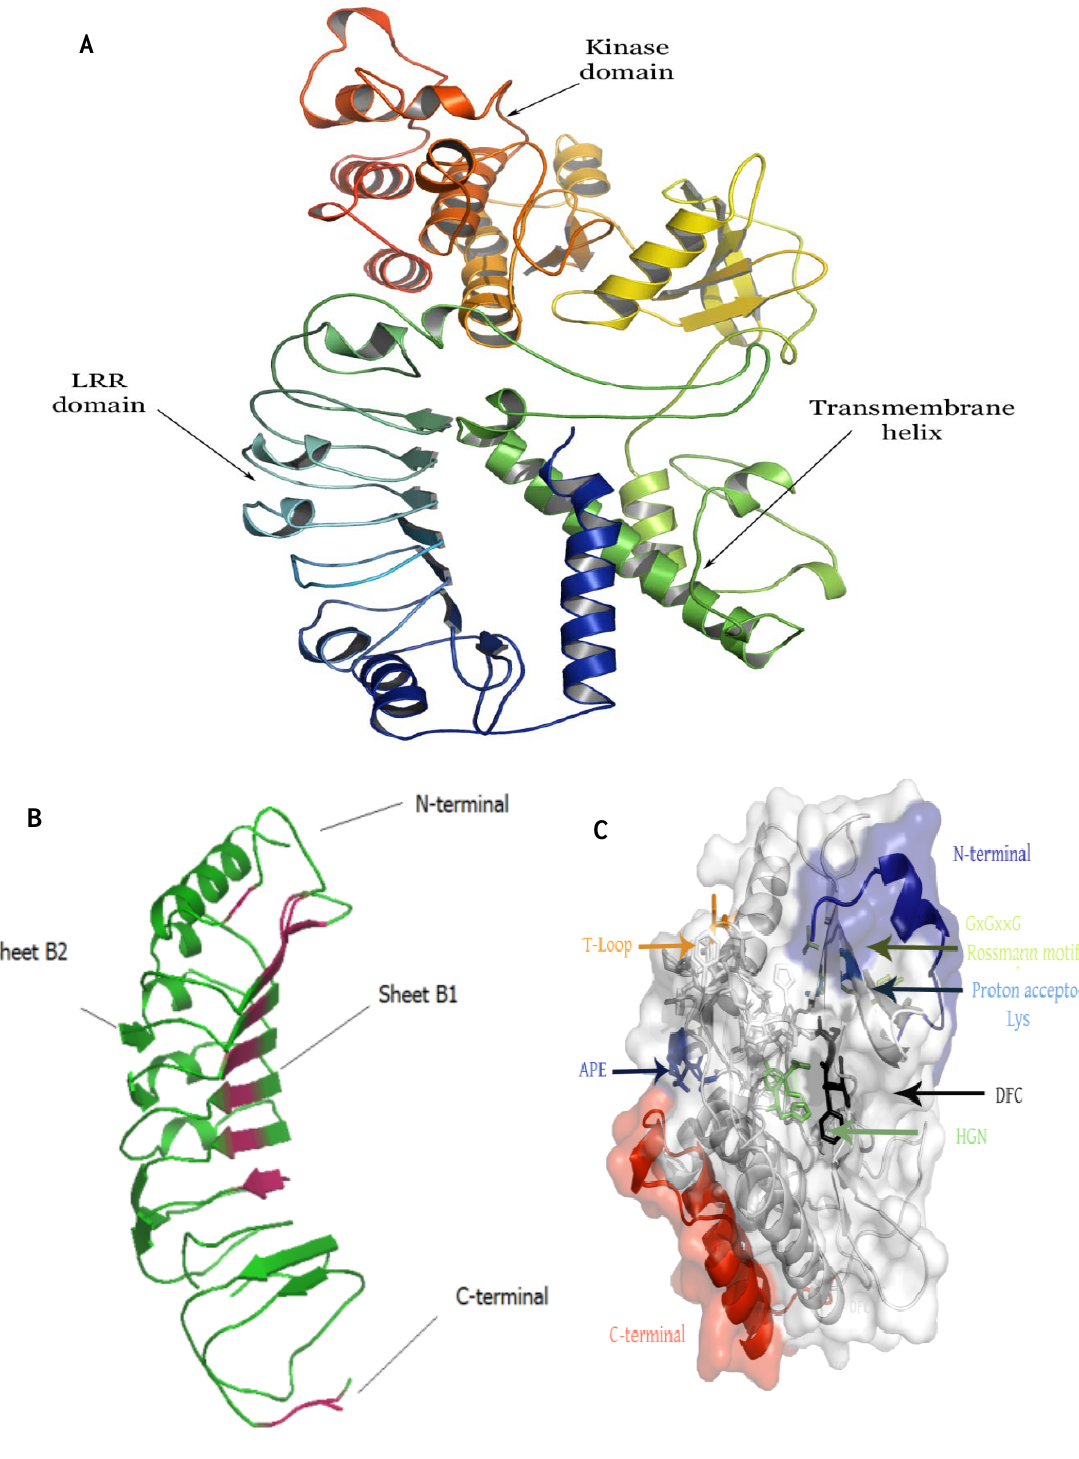
Figure 6. Predicted three dimensional structure of the OrufRPK1 protein. ( A ) The predicted OrufRPK1 protein structure contains an LRR domain (blue), kinase domain (red) and transmembrane helix (yellow); ( B ) The LRR domain of OrufRPK1 consists of β -sheets and helices within N and C terminals; ( C ) Several highly conserved residues highlighted within the kinase domain of the OrufRPK1